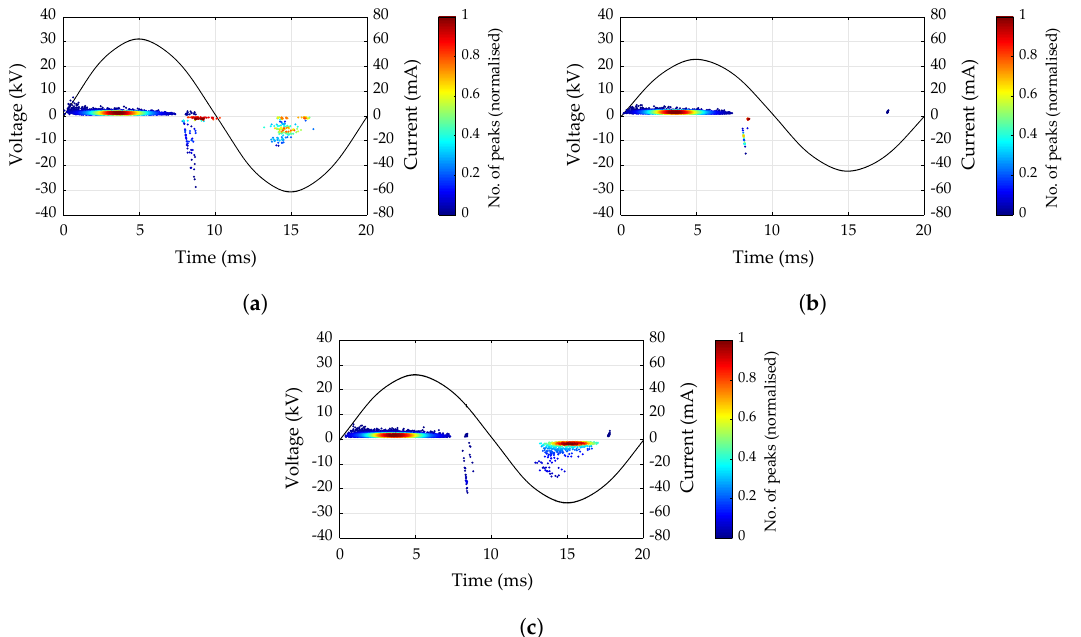
Figure 14. Current peaks densities for 4mm thickness insulator samples in carbon dioxide (CO 2 ) at 1bar absolute pressure: ( a ) PTFE, ( b ) epoxy resin and ( c ) silicone